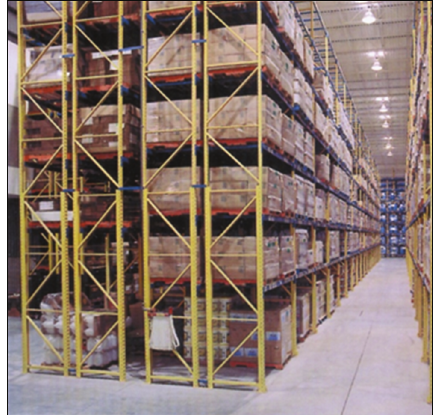
Figure 2: An actual photo of a double-deep rack.